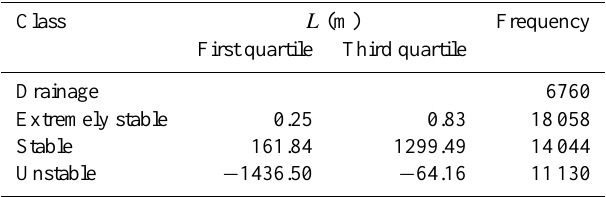
Table 1. Frequency of observations with first and third L quartiles for each class.